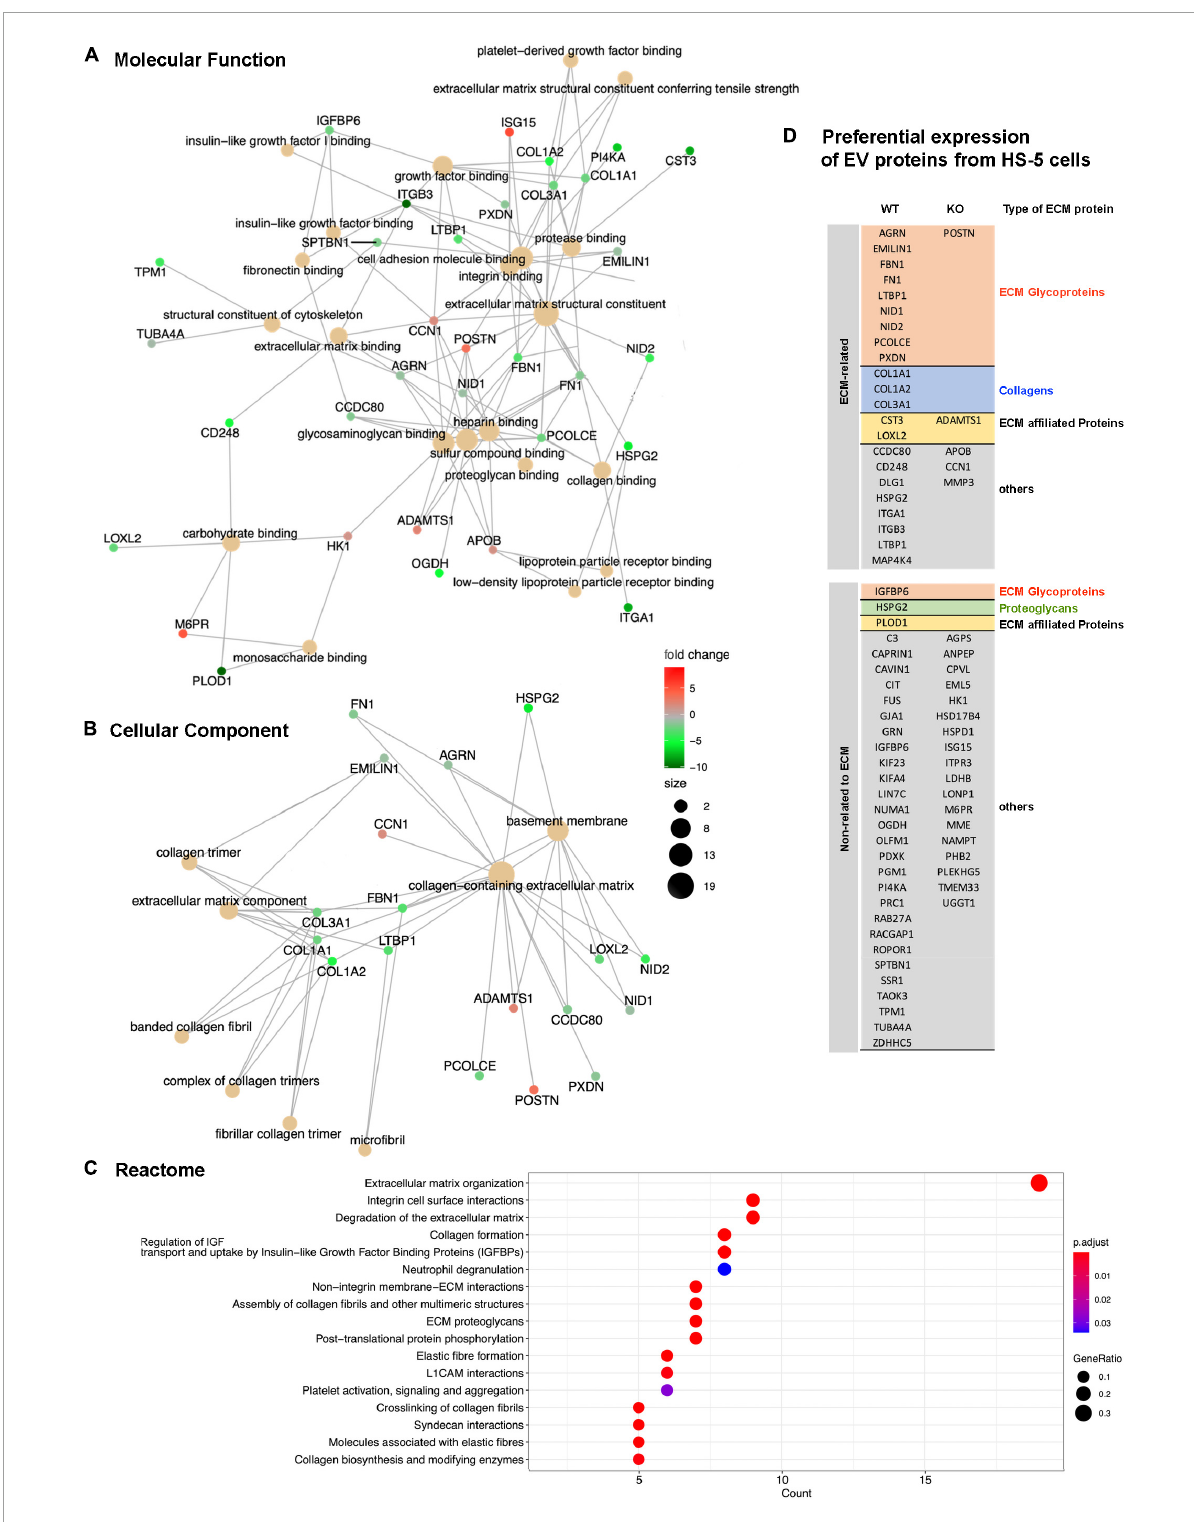
FIGURE6 Proteomic study of extracellular vesicles (EV) proteins from Lyn-proficient and deficient HS-5 cells. Differentially expressed proteins from EVs of Lyn-proficient and -deficient HS-5 cells were identified under the following condition ( p -adjusted ≤ 0.05; 1 ≤ log 2 fold change ≤ –1) ( Supplementary Table 1 ). Gene Ontology (GO) studies are depicted, i.e., molecular function (A) , cellular component (B) , and the Reactome (C) . Enrichment of proteins with a relation to the extracellular matrix are shown (D)